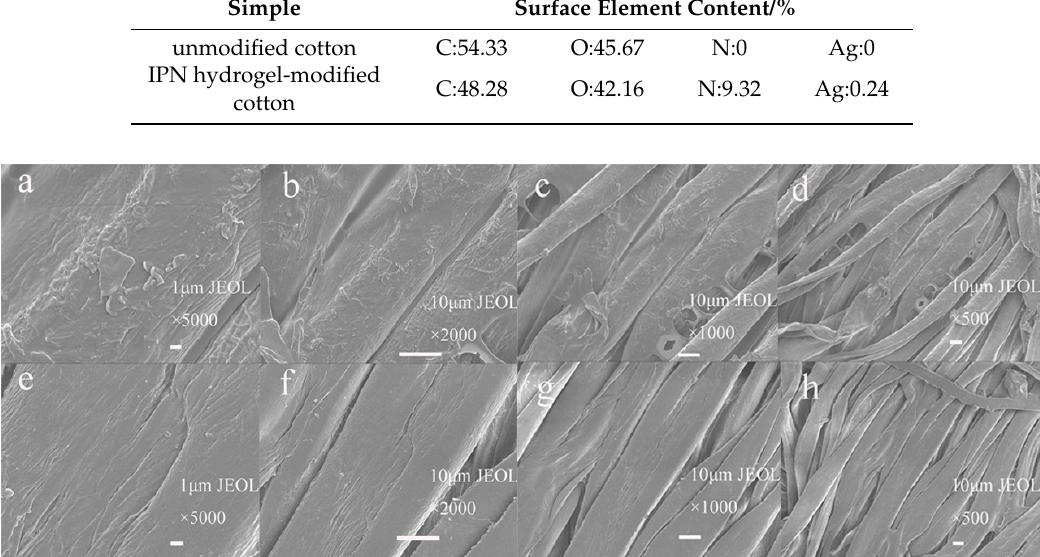
Figure 12. SEM of modified cotton ( a – d ) and unmodified cotton ( e – h ).